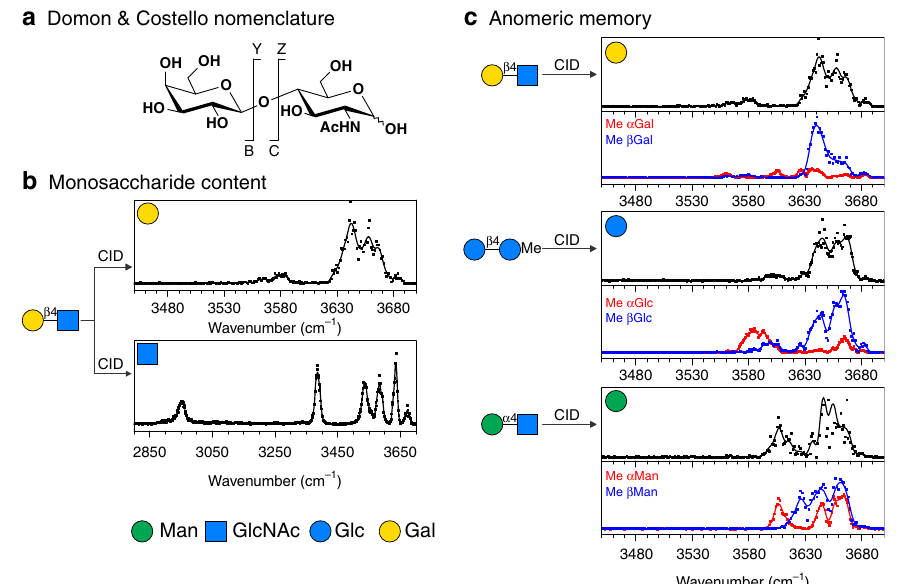
Fig. 2 Spectroscopic analysis of disaccharides fragments. a Nomenclature of carbohydrates MS fragments, after Domon and Costello 5 . b Monosaccharide fragments of Gal β 1,4GlcNAc. c Non-reducing fragments of Gal β 1,4GlcNAc; Glc β 1,4GlcMe and Man α 1,4GlcNAc. Methyl-anomers of Gal, Glc and Man are shown for comparison. Symbols from ref.